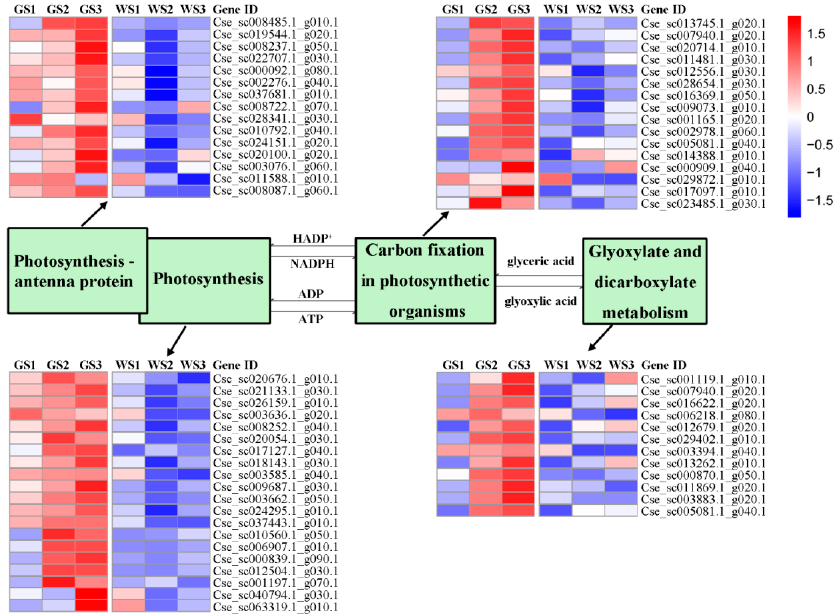
Figure 6. Expression heatmap of genes in key pathways that are differentially expressed between green and white pools at three stages of flower development.